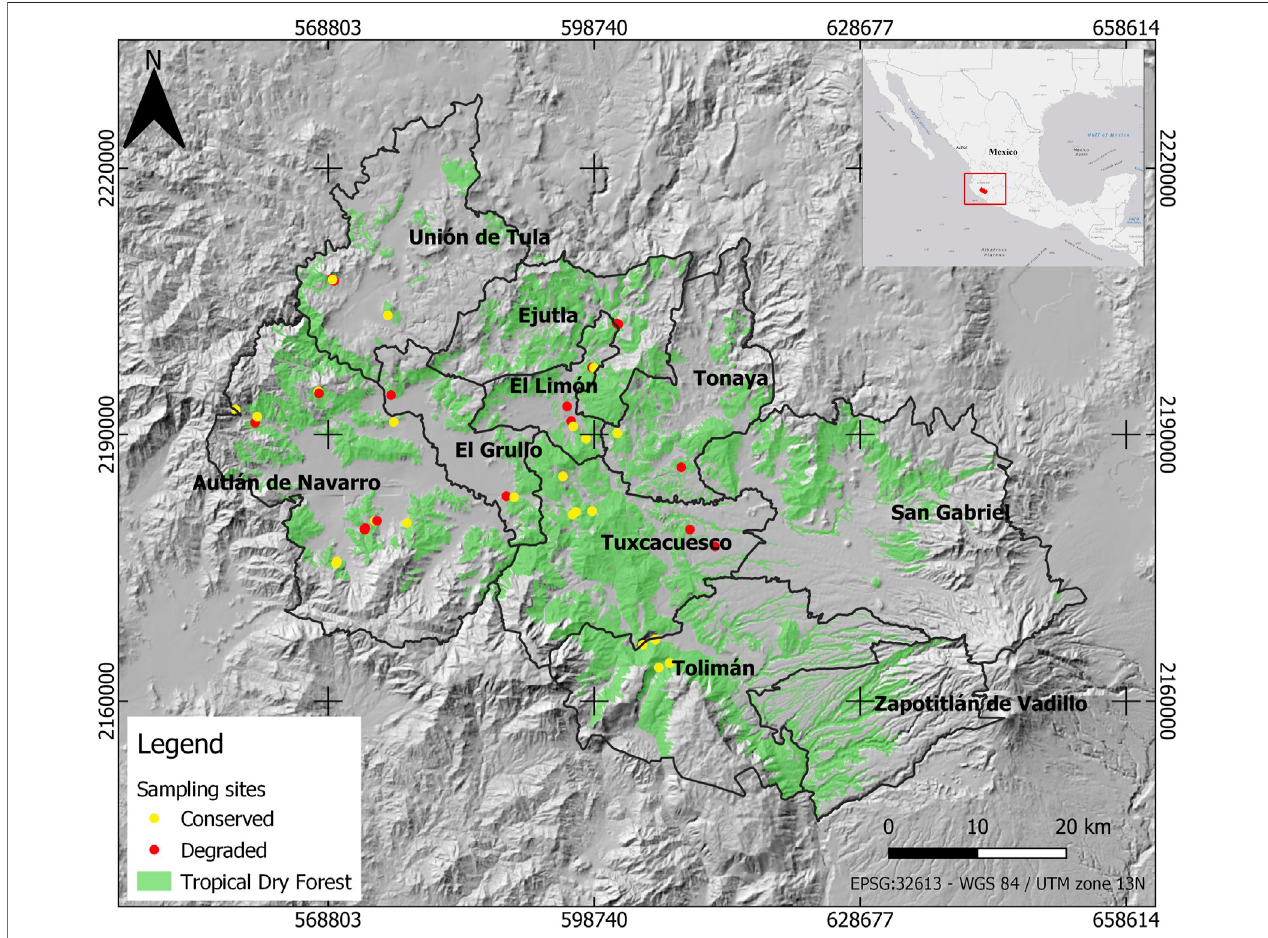
FIGURE1| Thestudyarealocation.Theyellowandreddotsindicateforestsurveyplotsandtheblacklinesrepresenttheboundariesofthemunicipalities.Thearea of tropical dry forests was delimited by visual interpretation of Landsat images of 2018. The map was projected to UTM 13N WGS84.